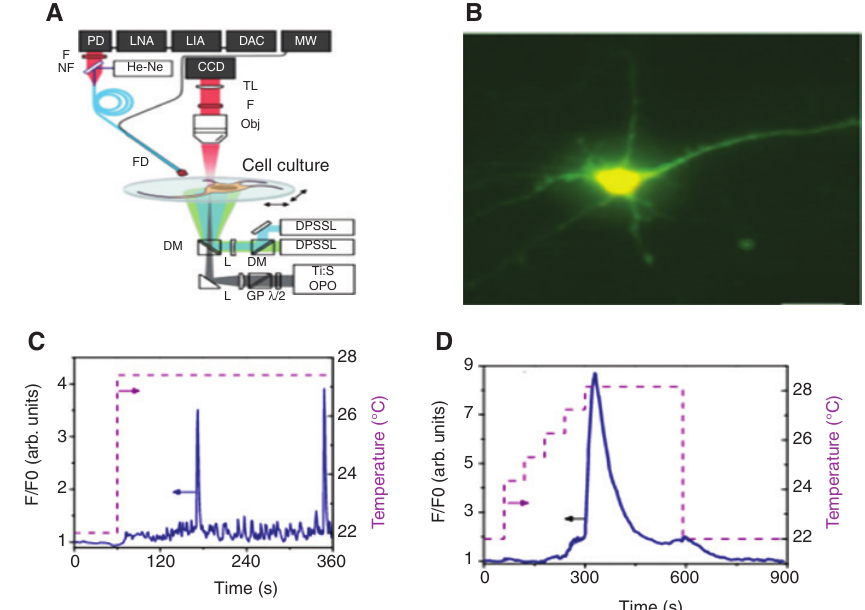
Figure 11: Temperature sensing capability of FNDs (NV center) in neurons. (A) An illustration of experimental setup of fiber-optic thermometry of single thermogenetically activated neurons, details about the system in [132]. (B) Fluorescence image of a laser-activated neuron. Fluorescence of the Ca + 2 sensor in a laser-activated neuron (solid line) increases (C) or decreases (D) as the temperature increases or decreases (dashed line) above or below the activation threshold for TRPA1-expressing neurons. Adapted from